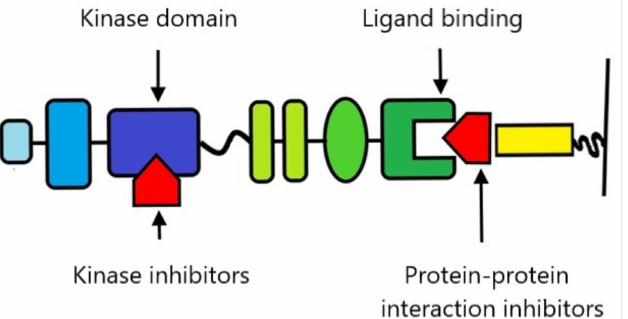
Figure 6. Schematic overview of the most important gripping points for Eph and ephrin therapy. Ki- nase inhibitors include nonselective compounds and second-generation selective inhibitors. Protein– protein inhibitors include antibodies, Eph and ephrin ectodomains, peptides, and small